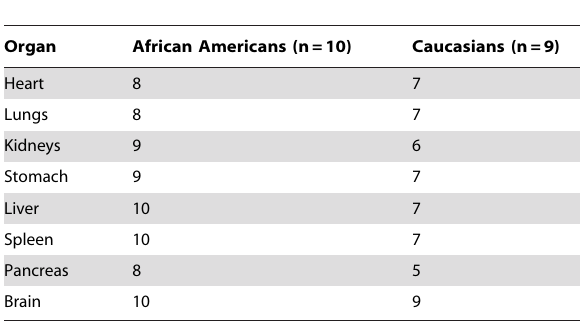
Table 2. Number of subjects in whom [ 11 C]d- methamphetamine measures were obtained for the various